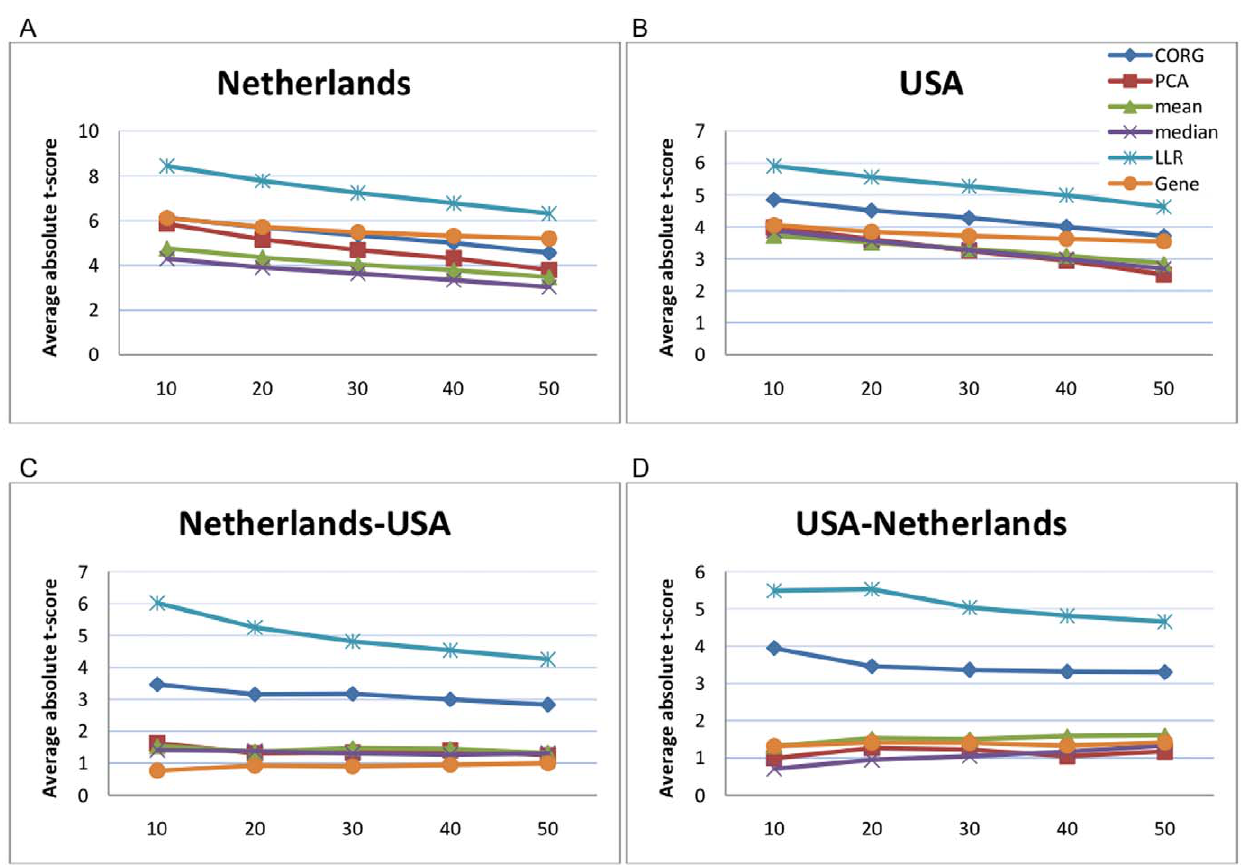
Figure 3. Discriminative power of prescreened pathway markers and single gene markers. (A) Mean absolute t -score of the top k ~ 10,20,30,40,50 ð Þ markers for the Netherlands breast cancer dataset. Pathway activities have been inferred using five different methods: CORG, PCA, mean, median, and LLR (proposed method). The discriminative power of the top gene markers was estimated for comparison (labeled as ‘‘Gene’’). (B) Mean absolute t -score of the top markers for the USA breast cancer dataset. (C) The markers were ranked based on the Netherlands dataset and the mean absolute t -score of the top k markers was computed based on the USA dataset. (D) The markers were ranked based on the USA dataset and the mean absolute t -score of the top markers was computed based on the Netherlands dataset.